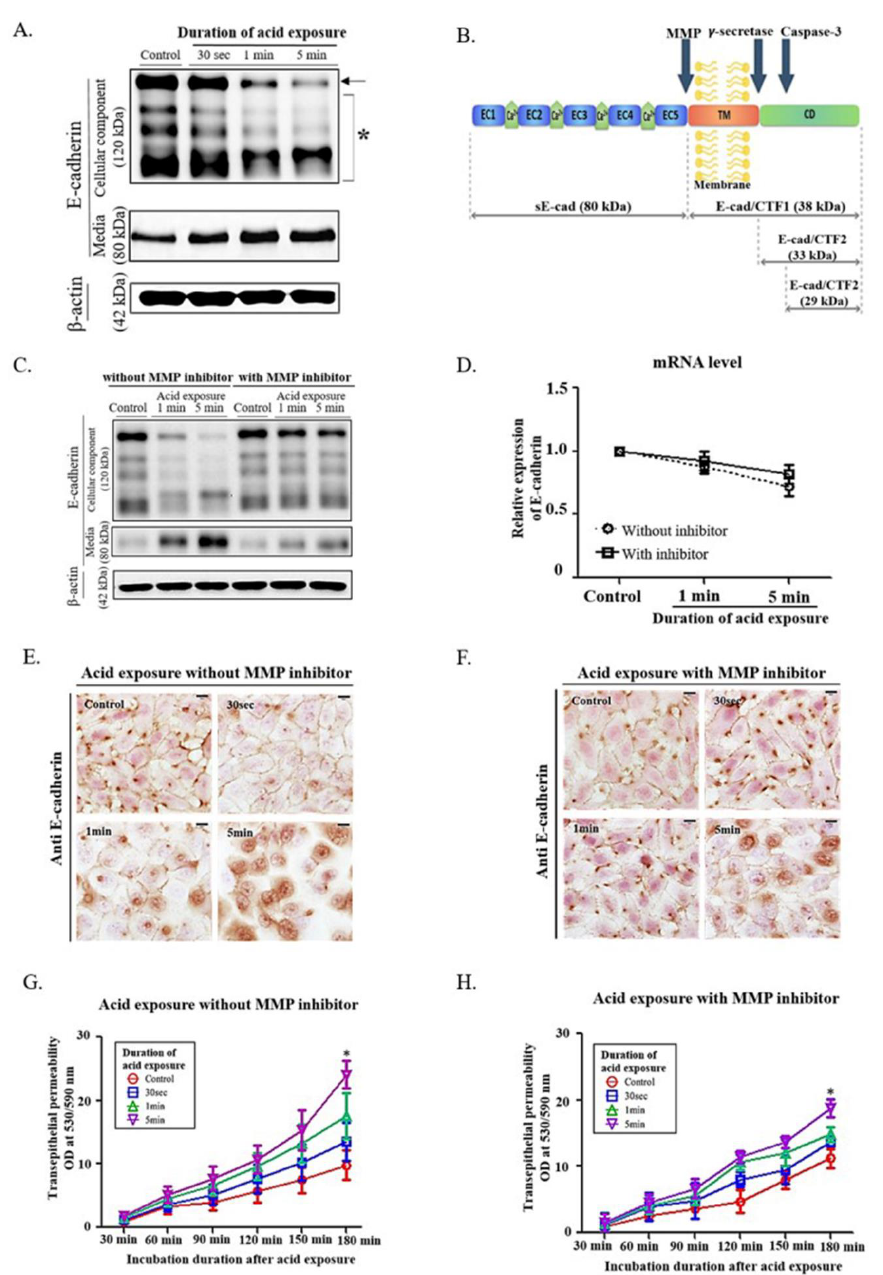
Figure 1. Effect of MMP inhibitor on changes of E-cadherin cleavage in human pharyngeal mucosal epithelial cells exposed to acidic media. ( A ) Evaluation of culture media shows an increase in levels of soluble 80-kDa E-cadherin (sE-cad) that is negatively correlated with the expression of full-length E-cadherin in the cell portions (arrow). Evidence of several cleavages is observed in the cellular component, and an increase in sE-cad is the most prominent change (asterisk). ( B ) Cleavage of full-length E-cadherin by MMPs generates sE-cad. CTF, C-terminal fragment; CD, cytoplasmic domain; EC, extracellular cadherin domain; TM, transmembrane domain; yellow structure, cell membrane. ( C ) Low expression of E-cadherin and high expression of sE-cad after acid exposure are significantly reversed by MMP inhibitor treatment. ( D ) mRNA level of E-cadherin is not changed irrespective of acid exposure and MMP inhibitor treatment. ( E , F ) Following acid exposure, the E-cadherin expression in the cell-cell junction is reduced, which is inhibited by MMP inhibitors. (bar, 50 µ m) ( G , H ) The slope of the transepithelial permeability increases as acid exposure time increases but is inhibited by MMP inhibitor treatment. The permeability decreases significantly by MMP inhibitors at 180 min of incubation (* p <